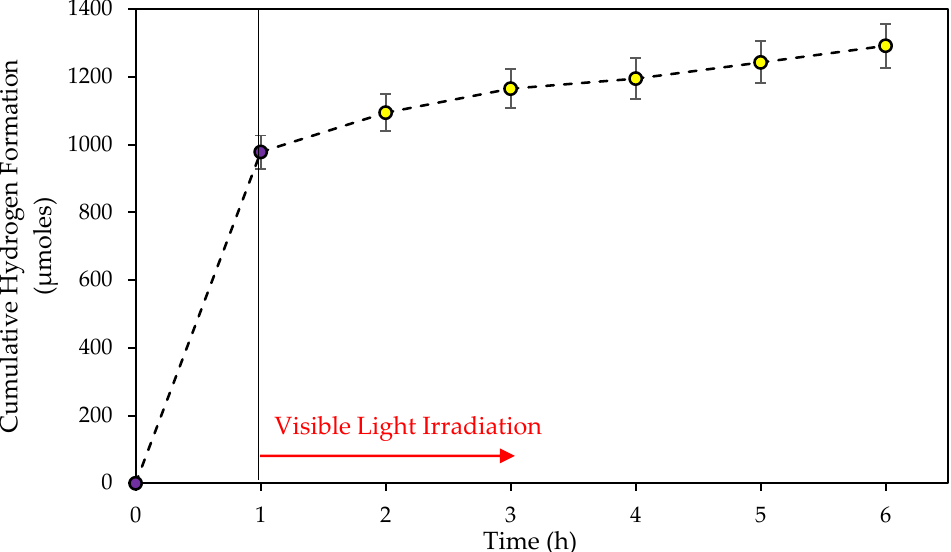
Figure 3. Cumulative formed hydrogen obtained with a 0.25 wt.% Pd-TiO 2 -VIS photocatalyst, which was photoreduced during 1 h of Near-UV Light Exposure, and then 5 h of visible light exposure. Conditions: photocatalyst concentration: 0.15 g/L, scavenger concentration: 2.0 v / v % ethanol.